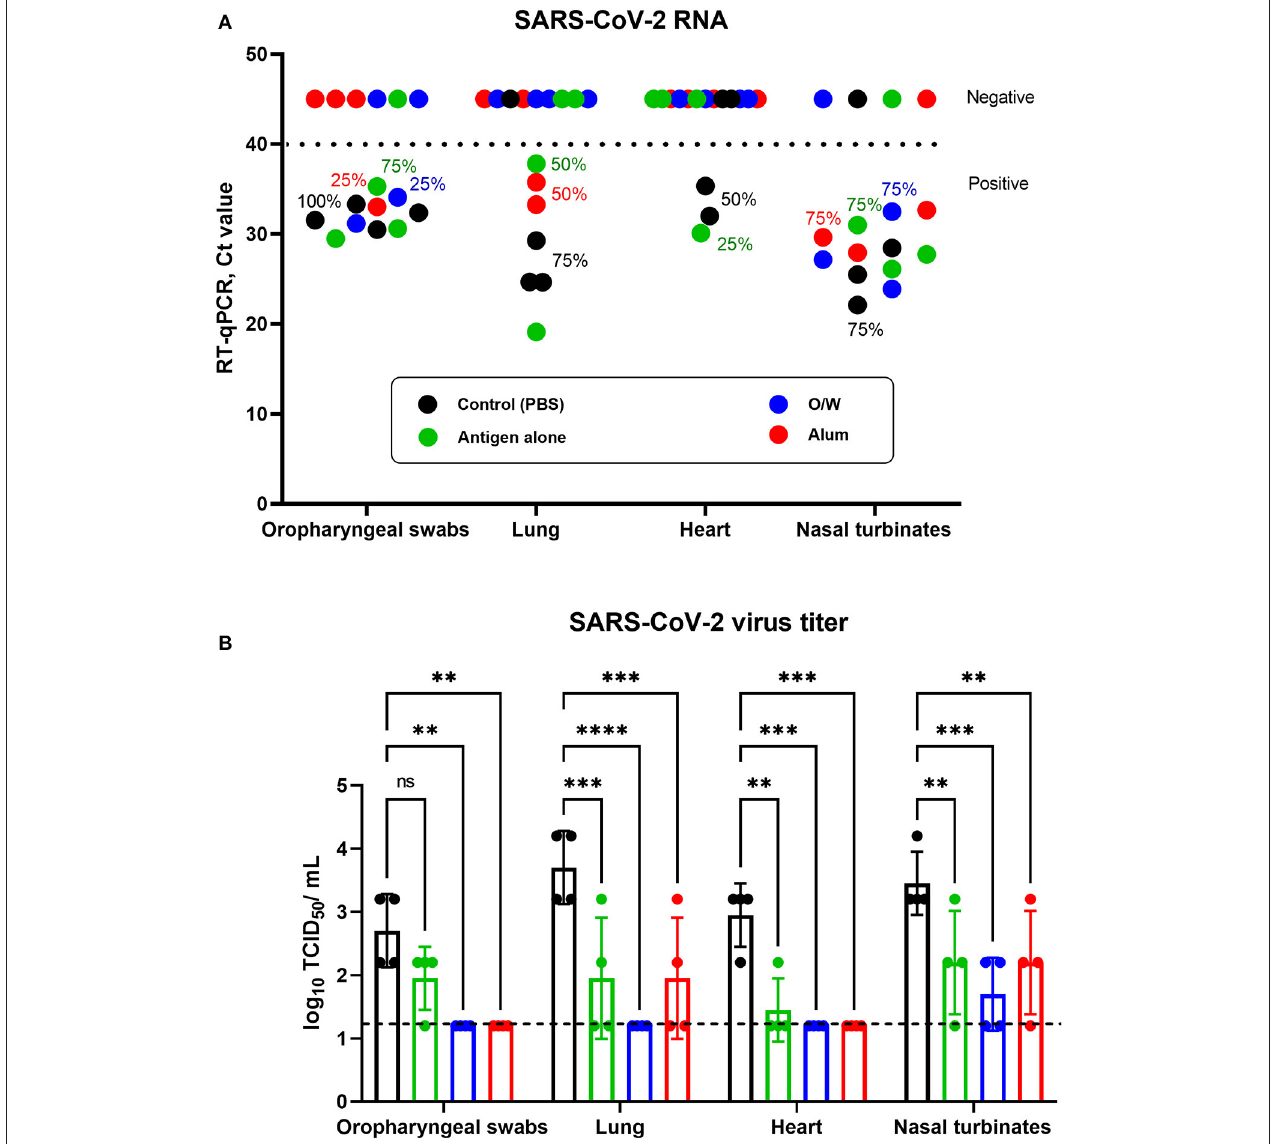
FIGURE 3 | Viral load in the respiratory tract and cardiovascular system of juvenile cats. Antigen was used at a dose of 5 µ g with O/W and alum adjuvants. For comparison, 5 µ g antigen was given without adjuvant and a negative PBS control. Animals inoculated with SARS-CoV-2 virus were euthanized on day 3 after challenge, and their organs were collected for viral RNA detection and virus titration. Shedding and presence of viral RNA (A) and viral titers (B) in oropharyngeal swabs, lung, heart, and nasal turbinates. The horizontal dashed lines in (A) and (B) indicate the upper and lower limits of detection, respectively. Differences between groups assessed using Dunnett’s multiple-comparisons test. For all comparisons, P < 0.05 was considered a significant difference. ** P < 0.01; *** P < 0.001; and **** P <